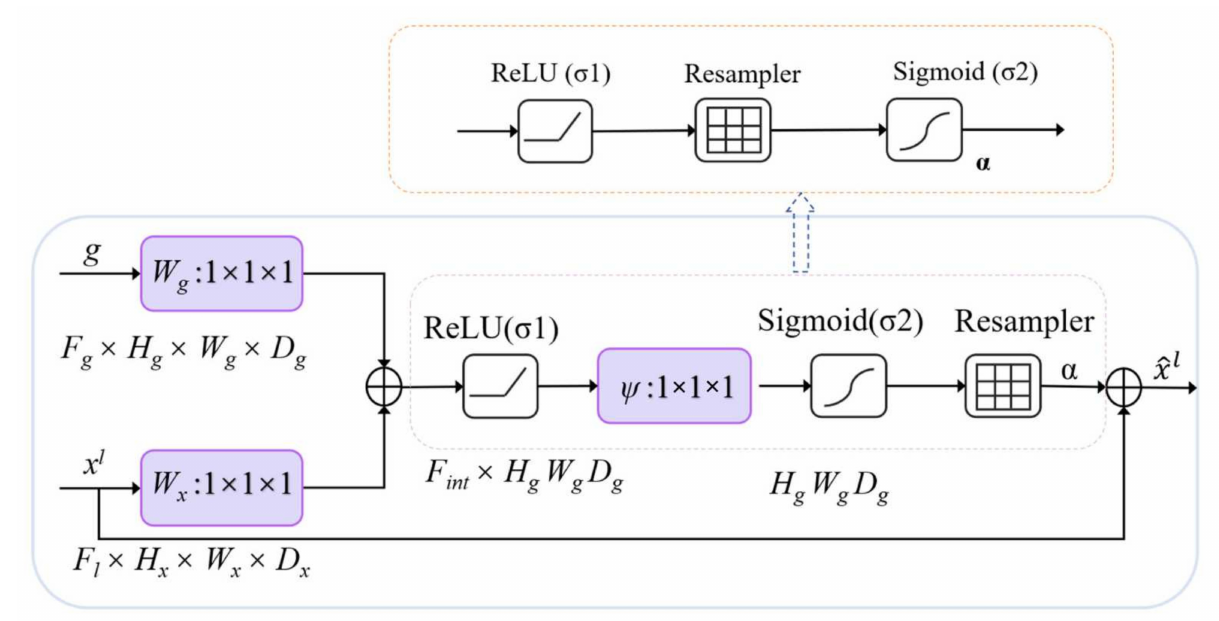
Figure 2. Structure of a AG module. The below shows the original AG module, and above is the part of the AG module changed position of the ‘Resampler’.